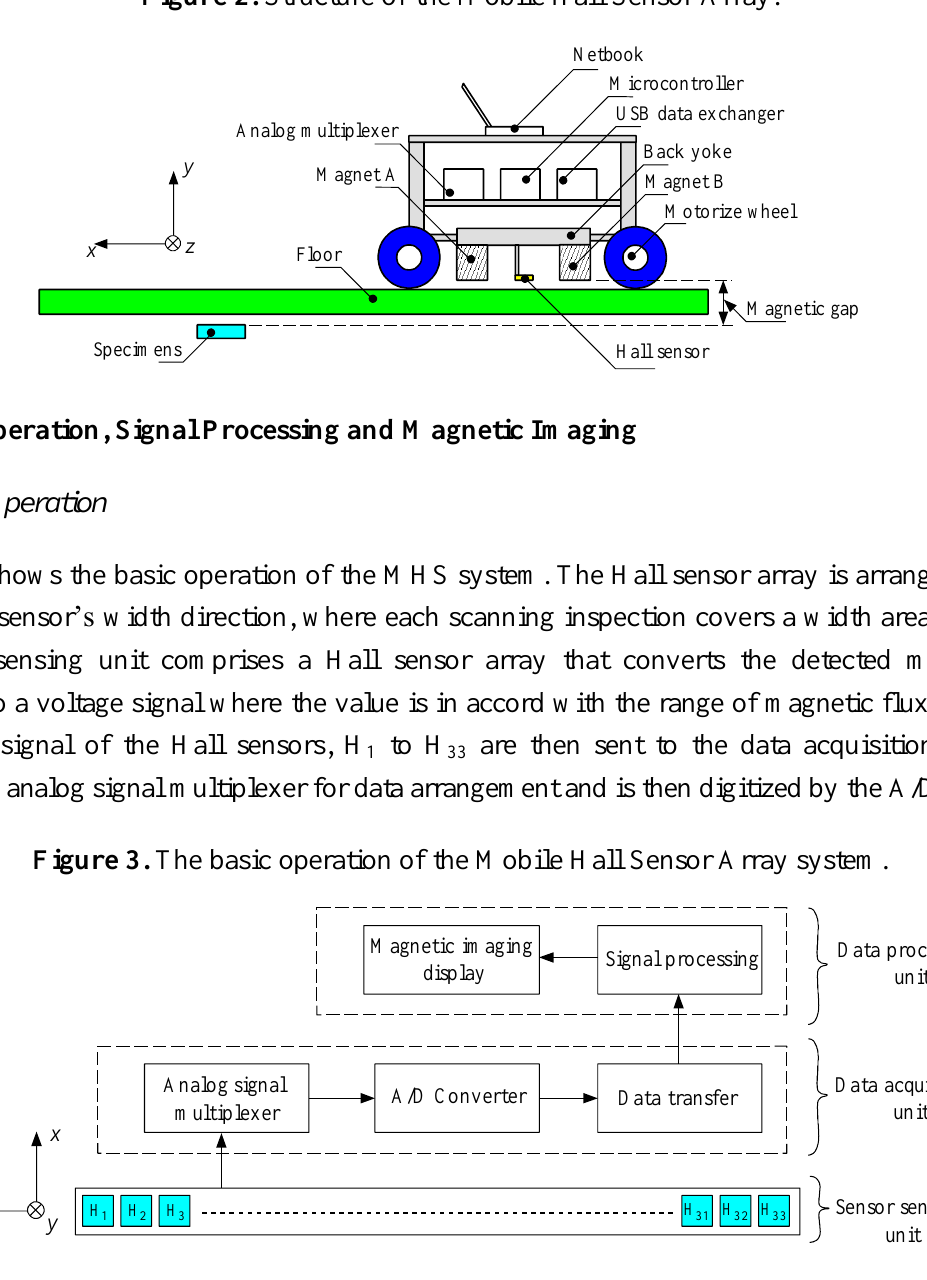
Figure 2. Structure of the Mobile Hall Sensor Array.